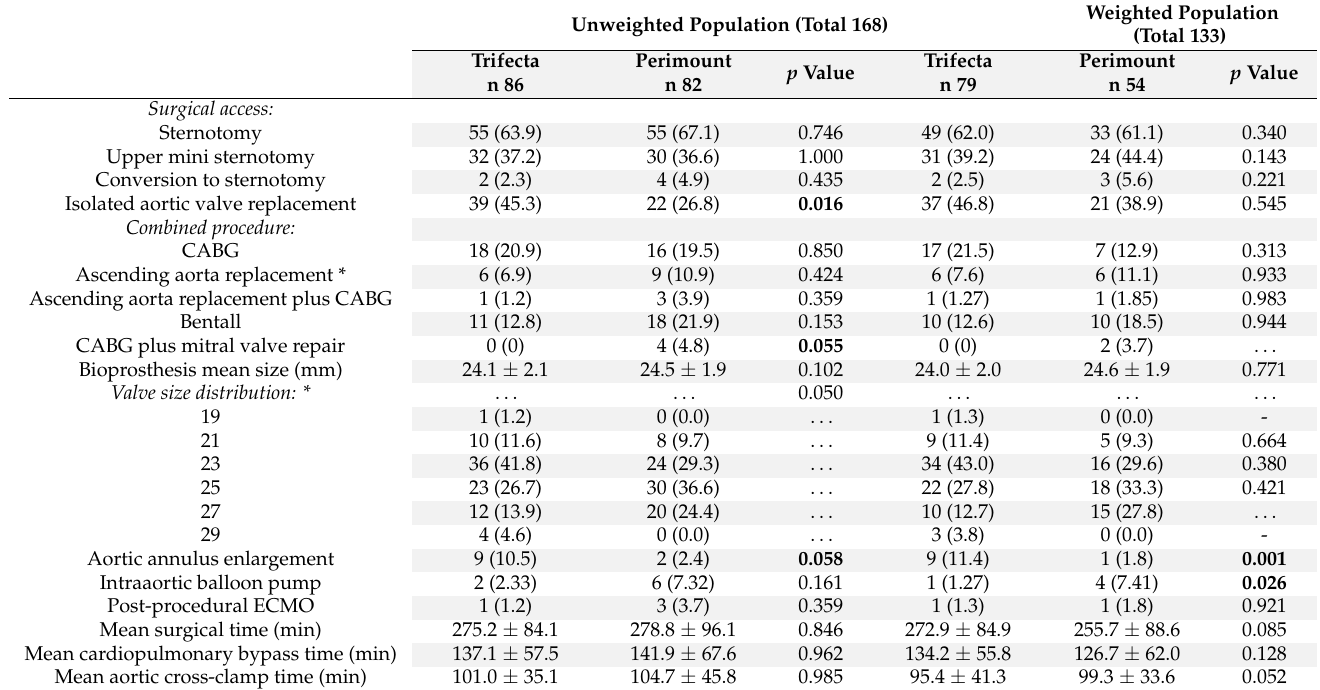
Table 2. Procedural